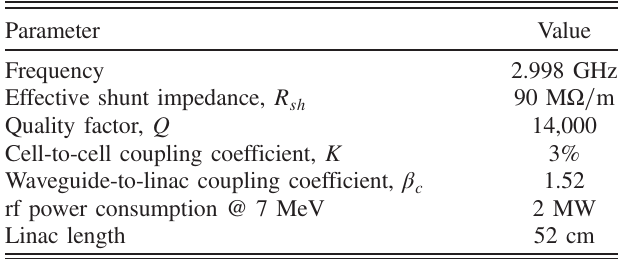
TABLE III. Output electron beam parameters.